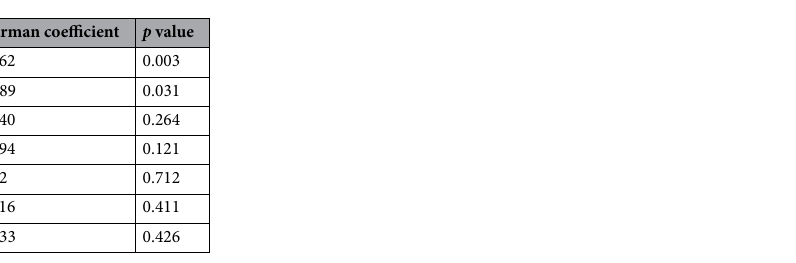
Table 3. Correlations between various factors of COPD and CD1b AM